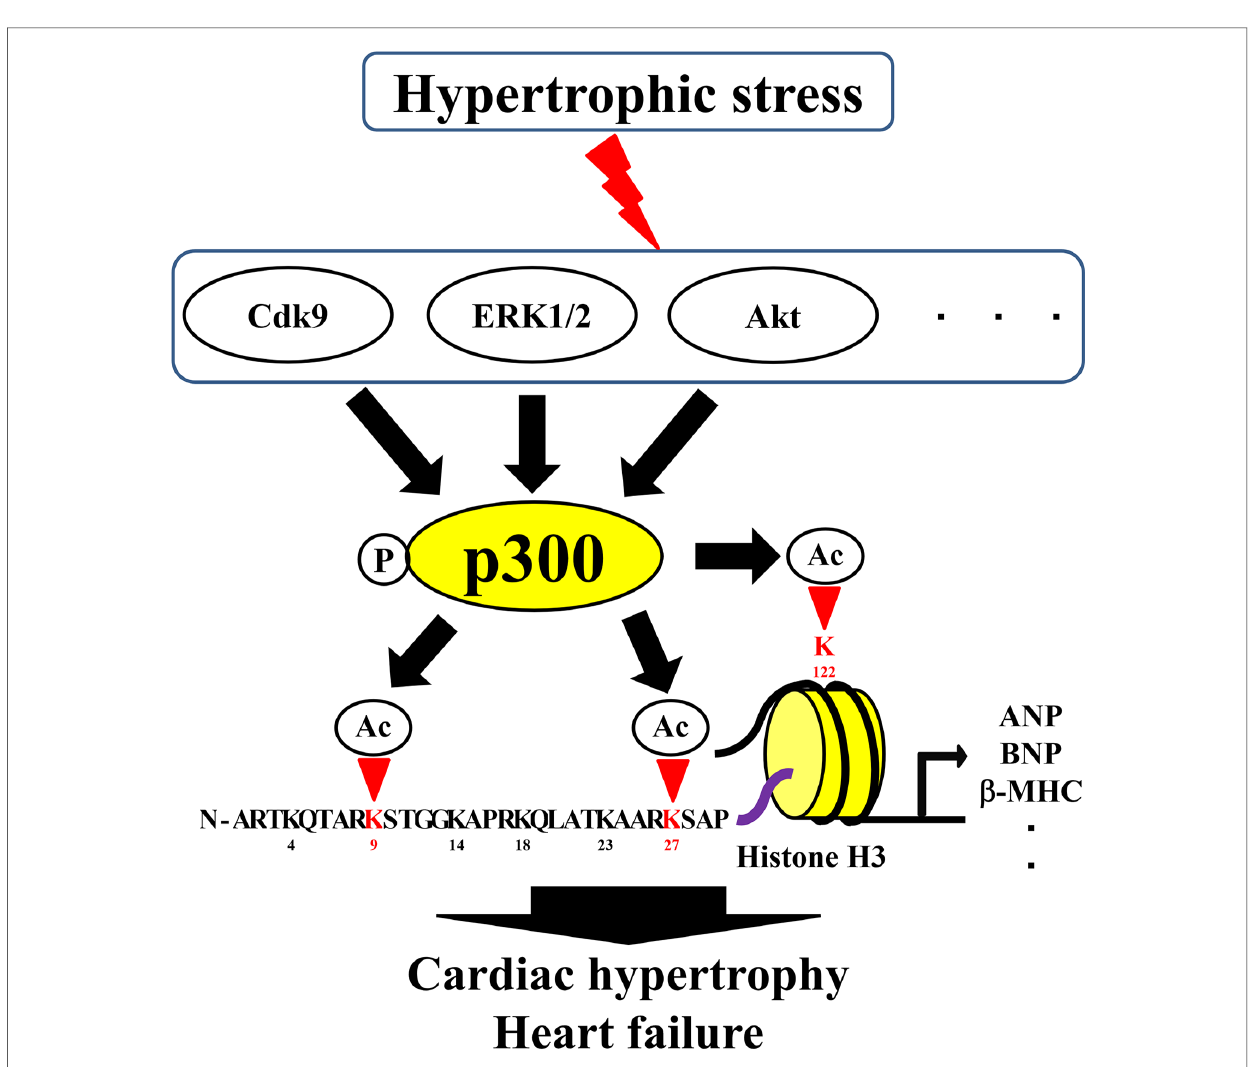
FIGURE 1 Roles of histone acetylation sites in cardiac hypertrophy and heart failure. Ac, acetylation; HATs, histone acetyltransferases; P,